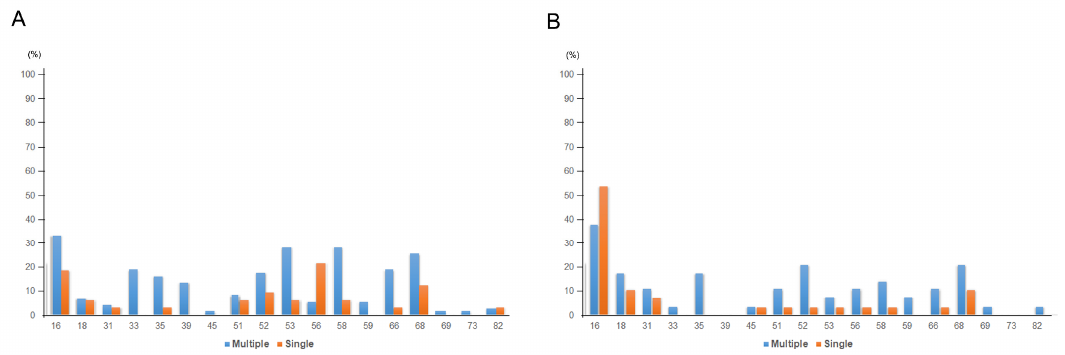
Figure 3. HPV genotype prevalence in ( A ) HSIL and ( B ) SQCC (single and multiple infection).